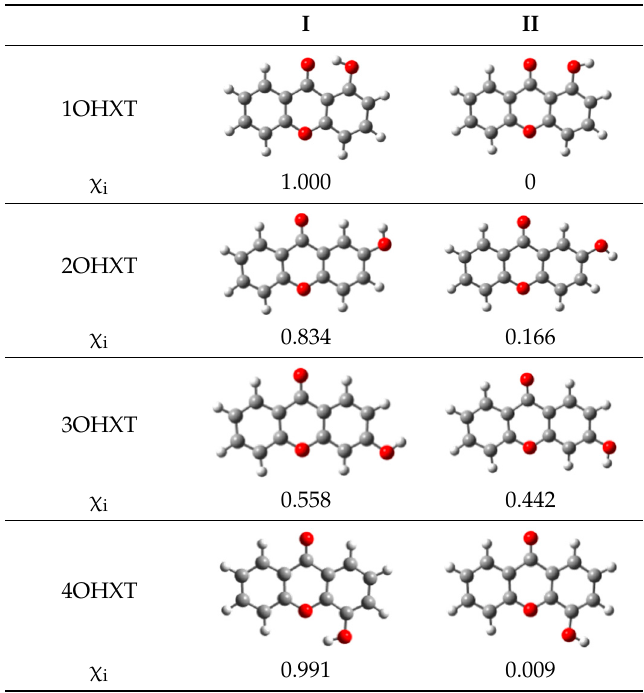
Table 1. Conformational composition, χ i , for most stable molecular geometries obtained by G3(MP2)//B3LYP composite method for monohydroxyxanthone isomers (1OHXT, 2OHXT, 3OHXT, and 4OHXT) a .